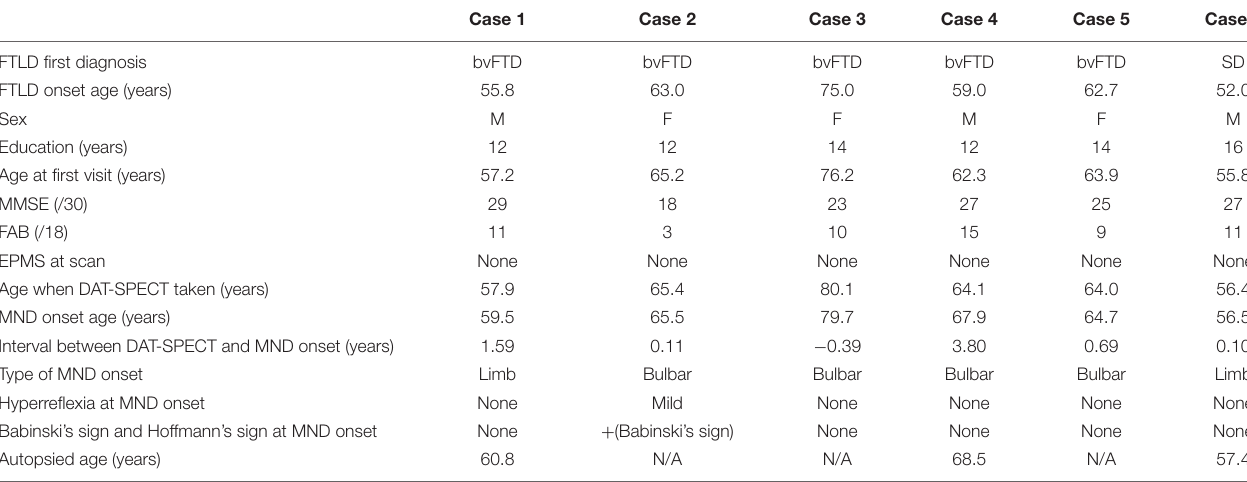
TABLE 1 | Characteristics and clinical data of the